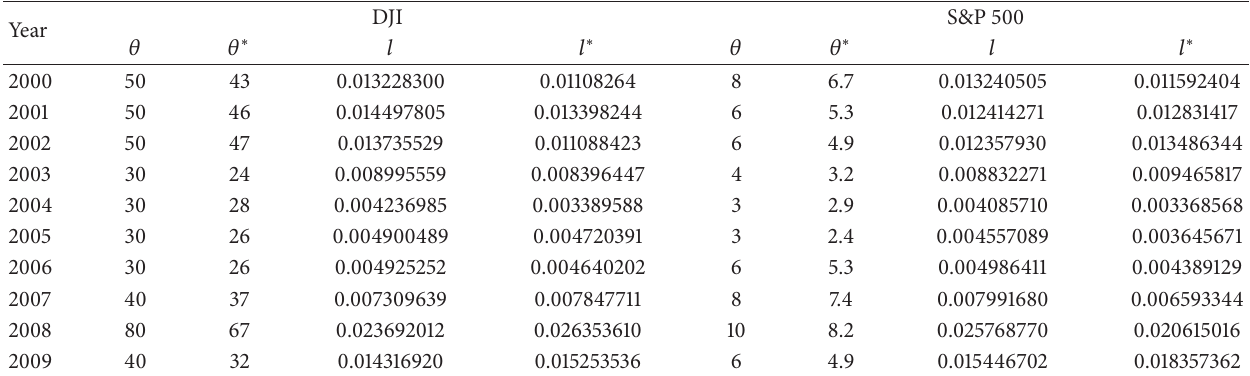
Table 3: Different length of intervals for DJI and S&P 500